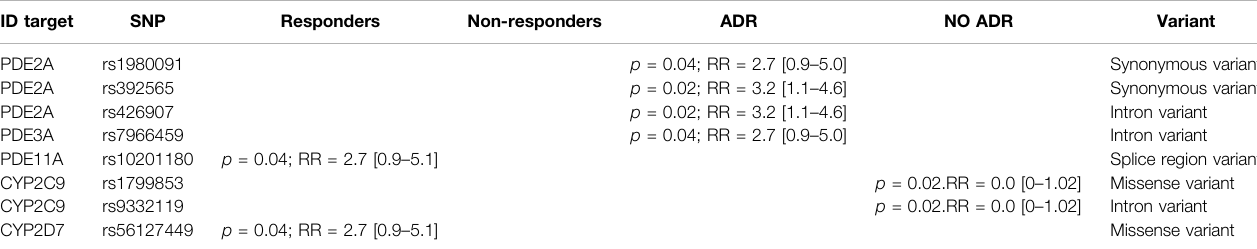
TABLE 3 | Differential clustering of gene variants detected in 28 male patients with erectile dysfunction included in the study, grouped according to drug response of presence of adverse drug reaction.